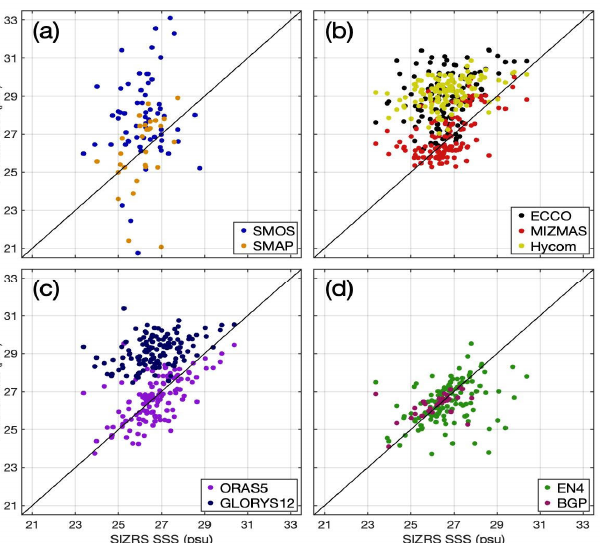
Figure 5. Scatter diagrams of sea surface salinity (SSS) of SIZRS (2 m) to ( a ) satellite missions, and of SIZRS (5 m) to ( b , c ) ocean model simulations, and ( d ) in–situ observations during SIZRS AXCTD drops. Black line signifies equivalent salinity values (psu). Table 2. Statistical analysis including the total drop average, the average difference, the correlation coefficient, and the p -value of sea surface salinity (psu) between SIZRS other salinity products at each SIZRS drop point.